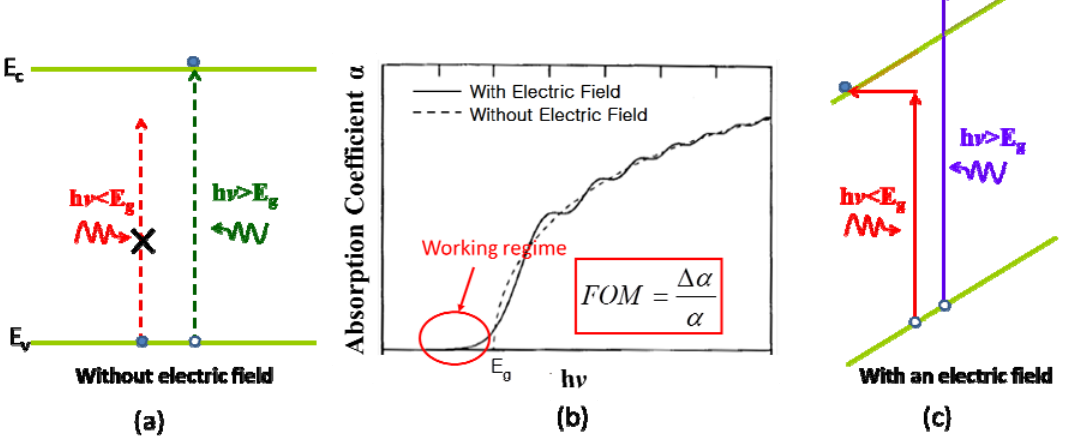
Figure 11. ( a ) Schematics of band-to-band optical absorption in a bulk semiconductor material without an applied electric field. ( b ) Absorption spectra of the material with and without an electric field. ( c ) Schematics of absorption process in a bulk